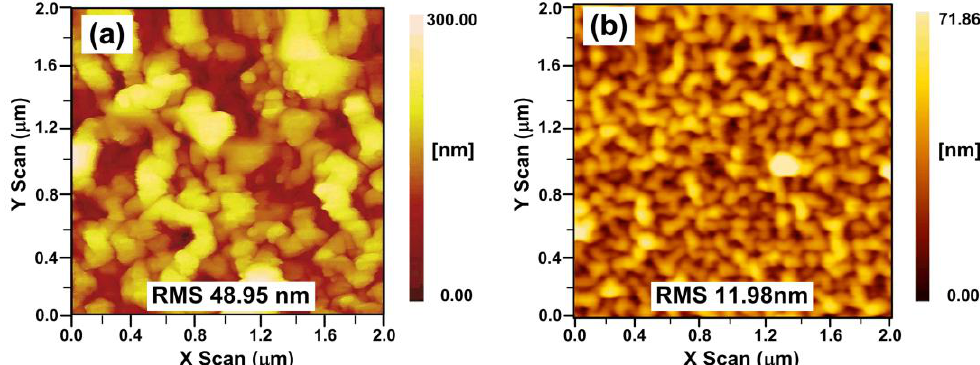
and ( b ) (PDDA/PAA) 4 10